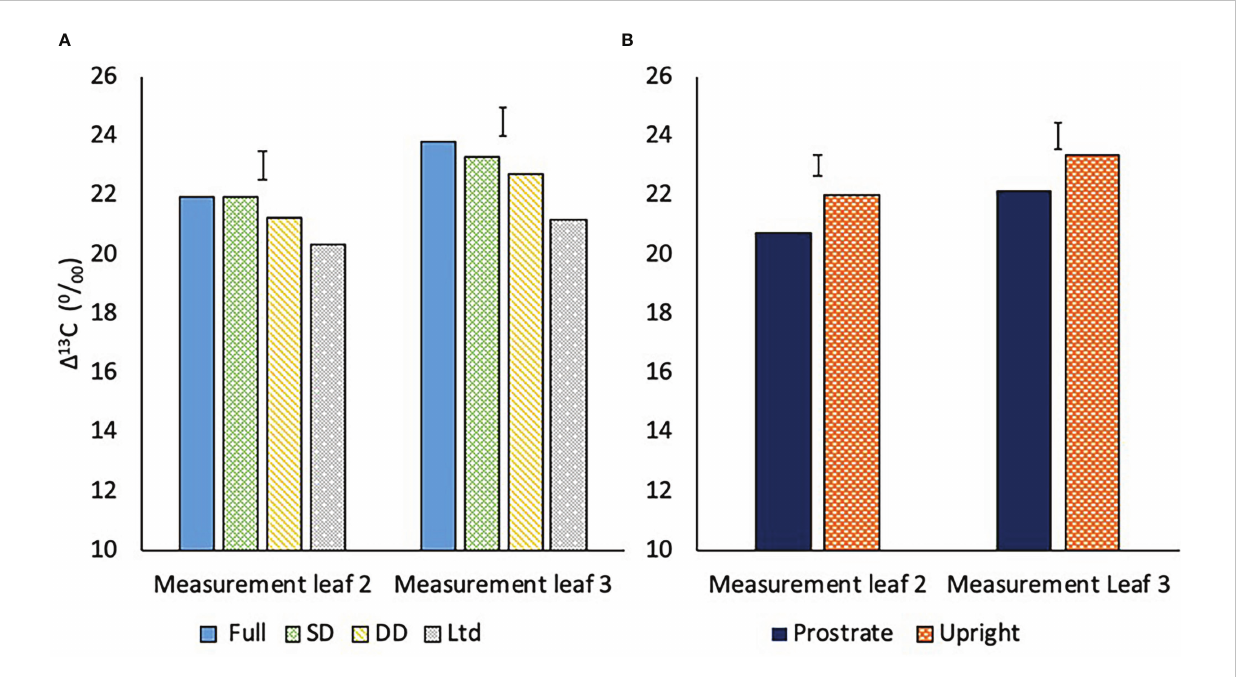
FIGURE 10 (A) The carbon isotope discrimination ( D 13 C) of two measurement leaves of sugar beet grown under four different irrigation regimes, fully irrigated (Full), single drought (SD), double drought (DD) and continually water limited (Ltd). Error bar shows irrigation LSD of measurement leaf 2 (P=0.016 DF=31 LSD=0.975) and measurement leaf 3 (P=0.001 DF=31 LSD=0.984). (B) The D 13 C of two sugar beet varieties with a prostrate and upright canopy averaged across four watering regimes. Error bar shows variety LSD of measurement leaf 2 (P=0.001 DF=31 LSD=0.701) and measurement leaf 3 (P=0.012 DF=31